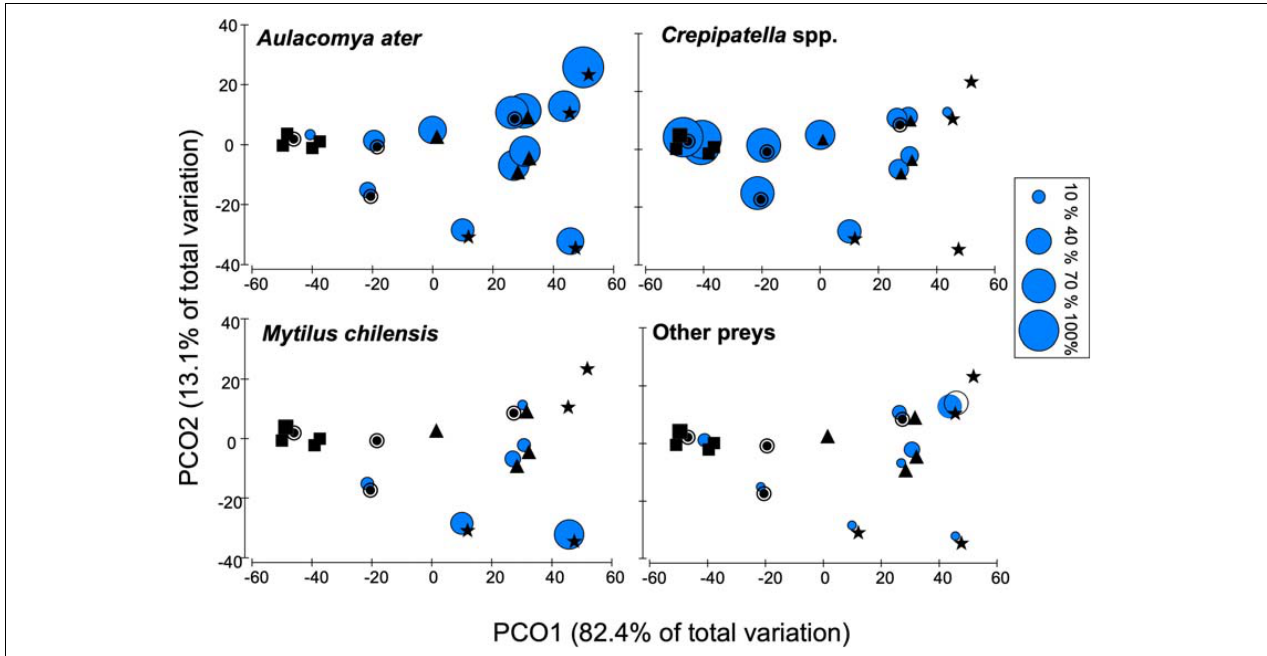
FIGURE 7 | Principal Coordinates Analysis (PCO) showing prey distinctly selected according to depth. Symbols represent different depth intervals (m); (cid:70) = 0–5, (cid:115) = > 5–10, = > 10–15, (cid:4) = > 15–20. The size of the circles represent the proportion of the main species preyed upon by Cosmasterias lurida.